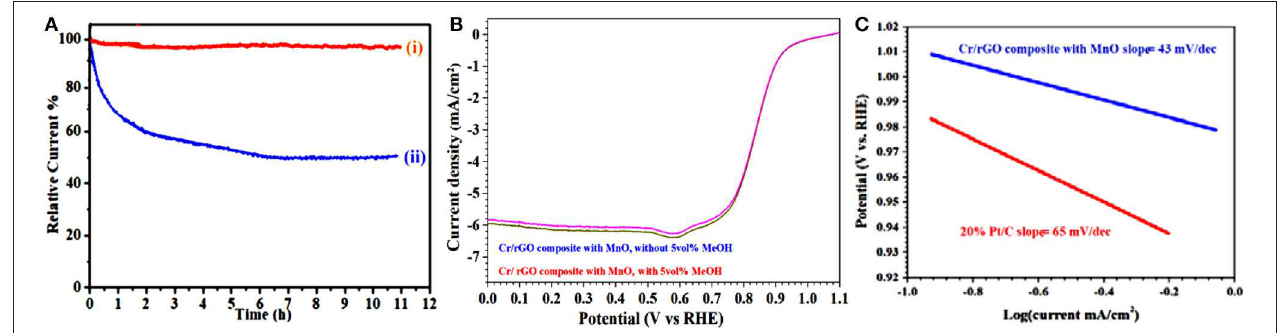
FIGURE 11 | (A) Chronoamperometric response at 0.6V of (i) Cr/rGO nanocomposite with MnO and (ii) Pt/C. (B) LSV curves of Cr/rGO nanocomposite with MnO, without/with 1M of MeOH. (C) Tafel plots calculated from RDE polarization curves. rGO, reduced graphene oxide; LSV, linear sweep voltammetry; RDE, rotating disk electrode.